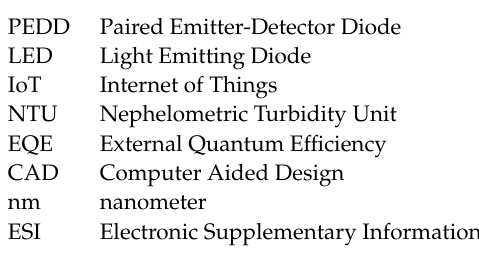
Figure A2: The beam of monochromatic light (300 W Xe lamp, PV Measurements QEX10) was masked to its smallest size (6 × 6 mm) before being focused to a narrow point. An LED was placed in the test position, with the top of the dome at the focal point of the beam. For each wavelength 42 measurements were taken using method 1 for each